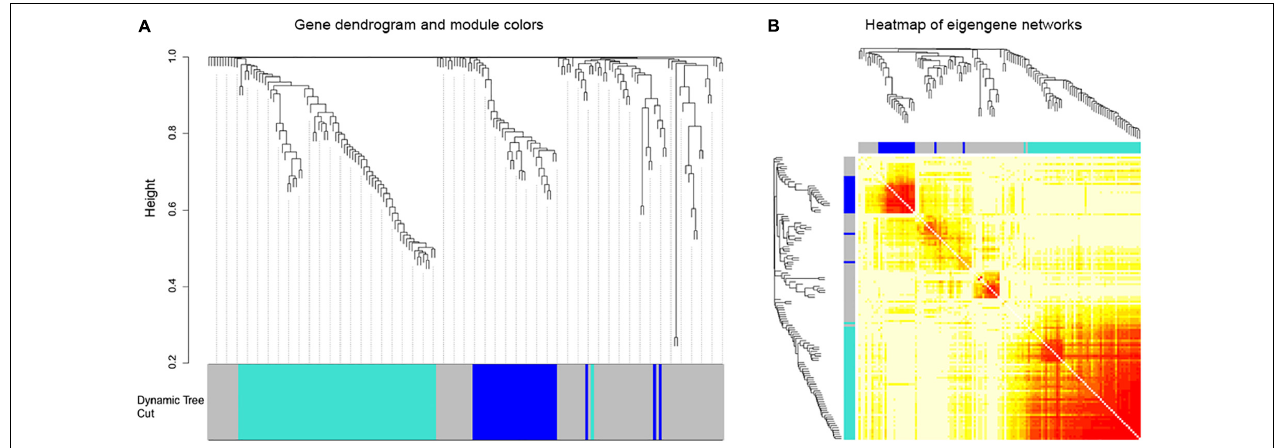
FIGURE 3 | Weighted gene co-expression network of glioblastoma. (A) Gene dendrograms obtained by average linkage hierarchical clustering of 185 genes based on consensus Topological Overlap with the corresponding module colors indicated by the color row. (B) The eigengene networks were shown as heatmap. The deeper the color expressed a high